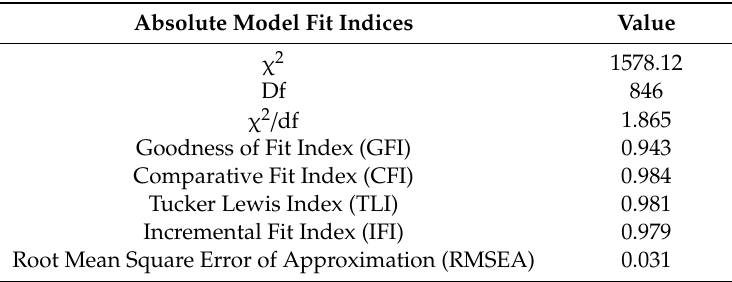
Table 6. Model fit